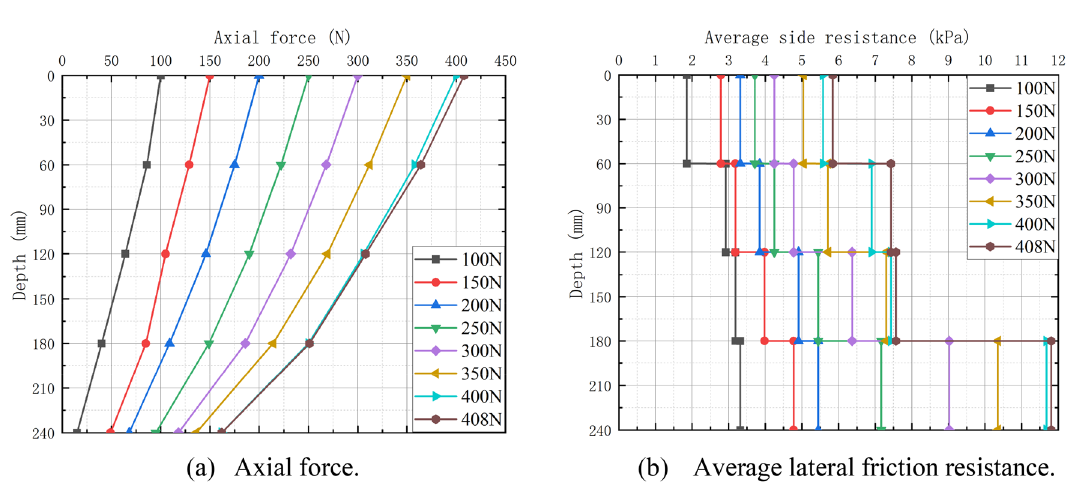
Figure 6. Soil displacement vector diagram.